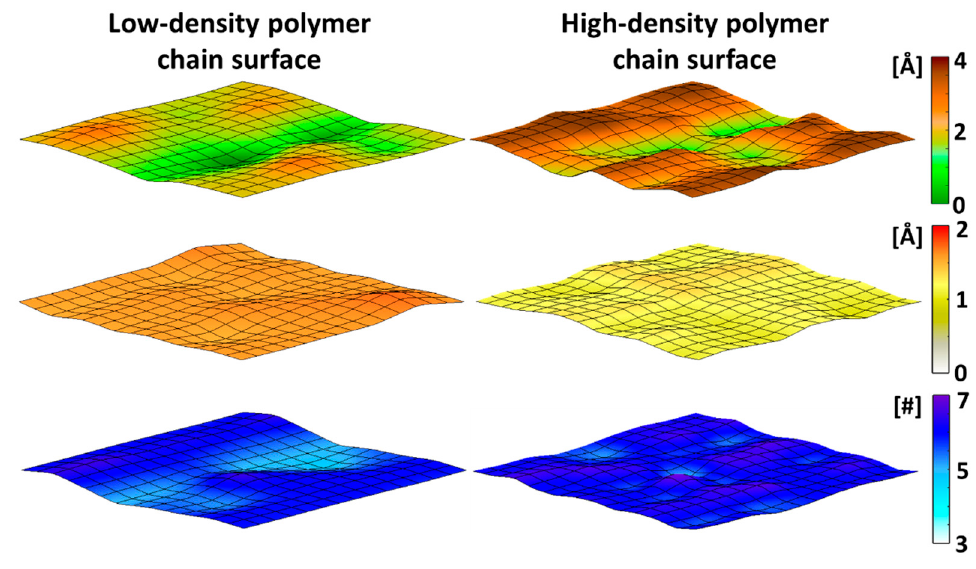
Figure 2. The averaged topology heights of the polymer chains (top), the RMSF of the polymer chains (middle), and water hydration of the polymer chains (bottom), i.e., number of water molecules around the polymer chains, at low-density and high-density surfaces in the absence of the foulant.